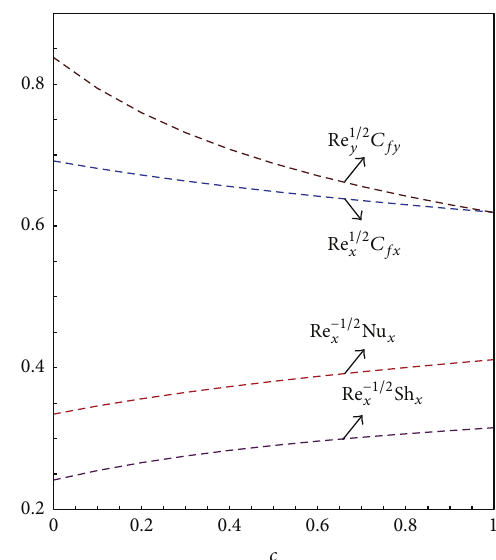
Figure 2: Graphs of skin friction coefficients, Nusselt and Sherwood numbers. 𝑁 𝑏 = 𝑁 𝑡 = 𝑁 𝑟 = 0.1 and Le = 1.0 .